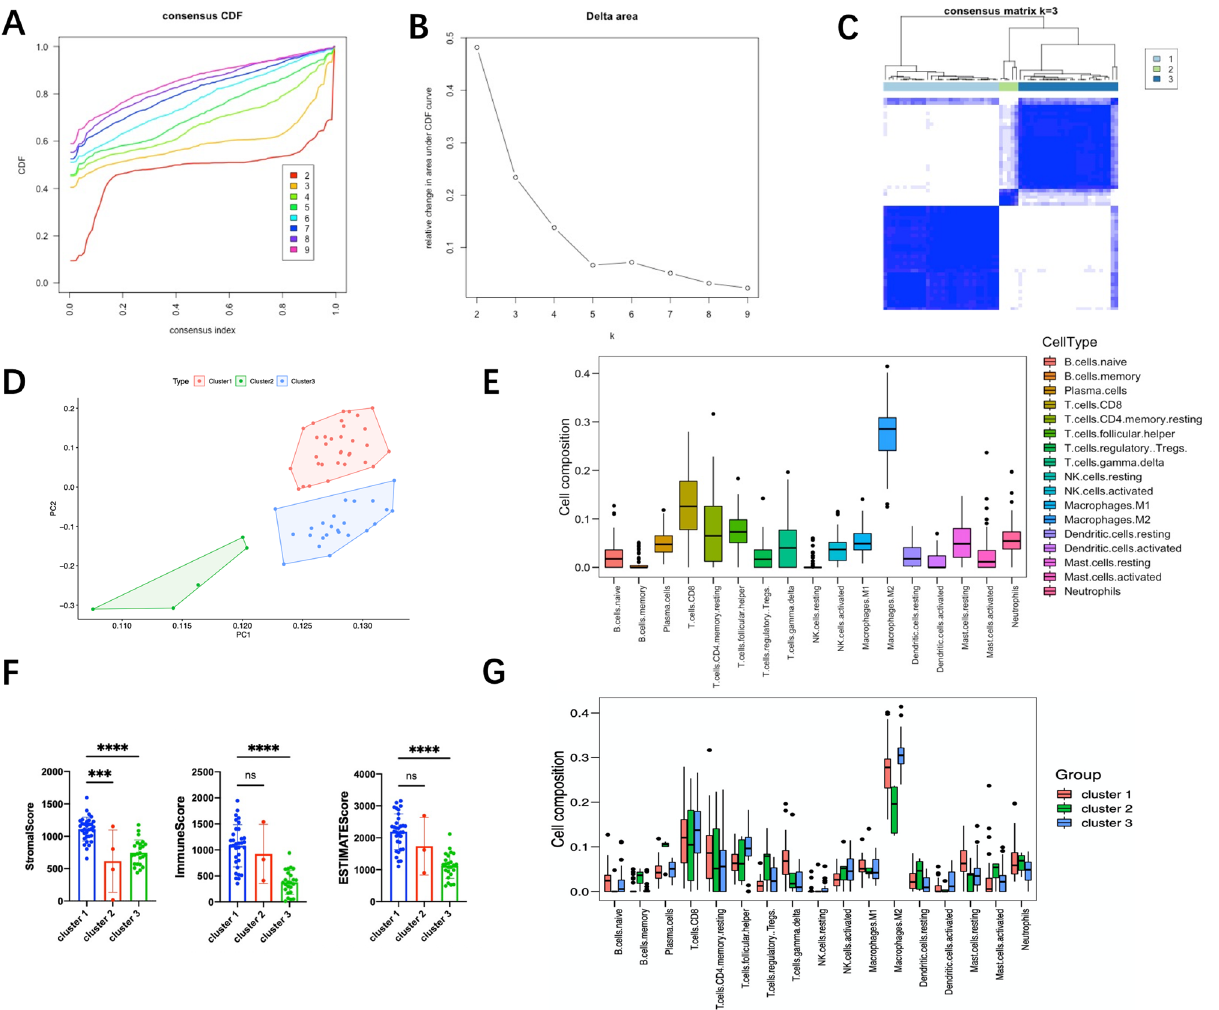
Figure 4. Identification of nonparoxysmal AF subtypes and their immune environment. ( A ) Cumulative distribution function (CDF) plots. ( B ) Delta area plot. ( C ) Consensus matrix plot (‘ConsensusClusterPlus’ package). ( D ) Principal component analysis of AF samples. ( E ) Immune cell abundance histogram in AF samples estimated using CIBERSORT. ( F ) Stromal/immune scores in three different clusters using ESTIMATE. ( G ) Immune cell abundance histogram of different clusters of AF samples estimated using